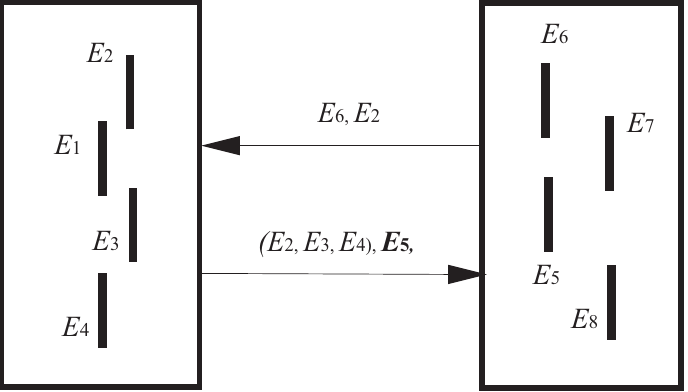
Figure 6. Graphical representation of the hierarchical